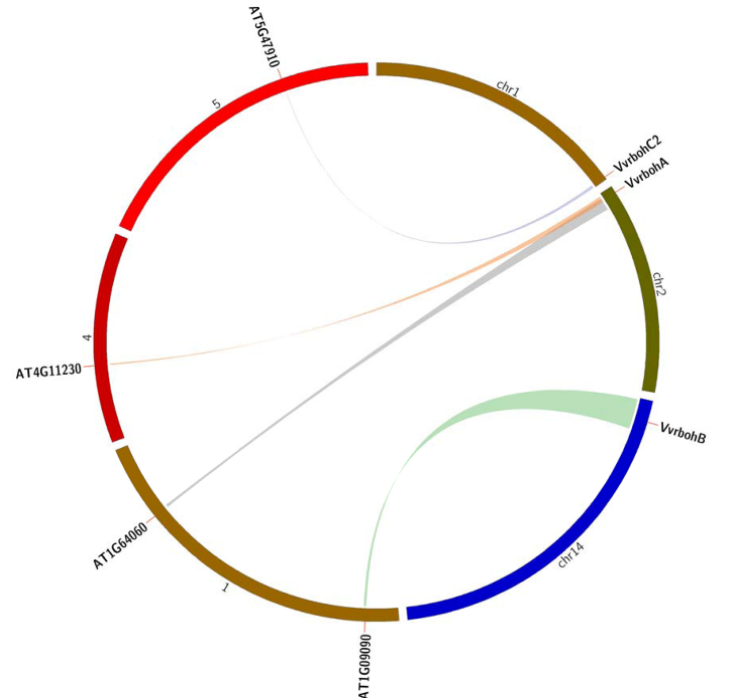
Figure 4. Synteny analysis of rboh genes from grape and Arabidopsis. The positions of related Vvrboh genes and Atrboh genes are depicted in the grape chromosomes (chr1, 2 and 14) and Arabidopsis chromosomes (1, 4 and 5), respectively. Colored lines connecting two chromosomal regions indicate syntenic regions between grape and Arabidopsis